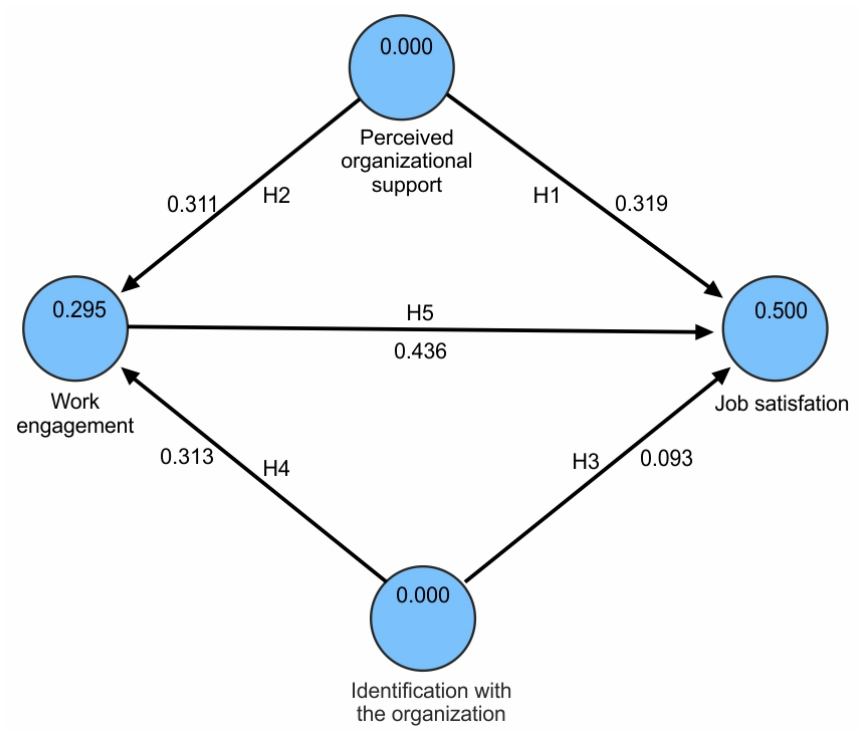
Figure 2. Smart PLS output for structural model. As can be seen from the final evaluation of the structural model (see Table 5), identifica- tion with an organization does not influence job satisfaction. However, all other constructs have significant